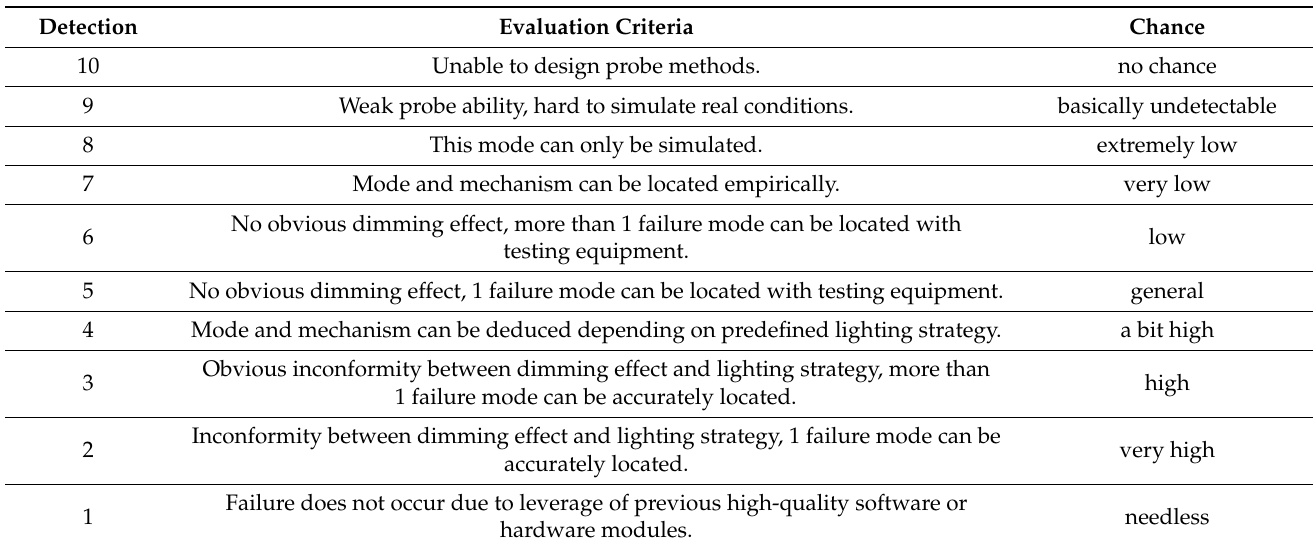
Table 9. Evaluation criteria for detection